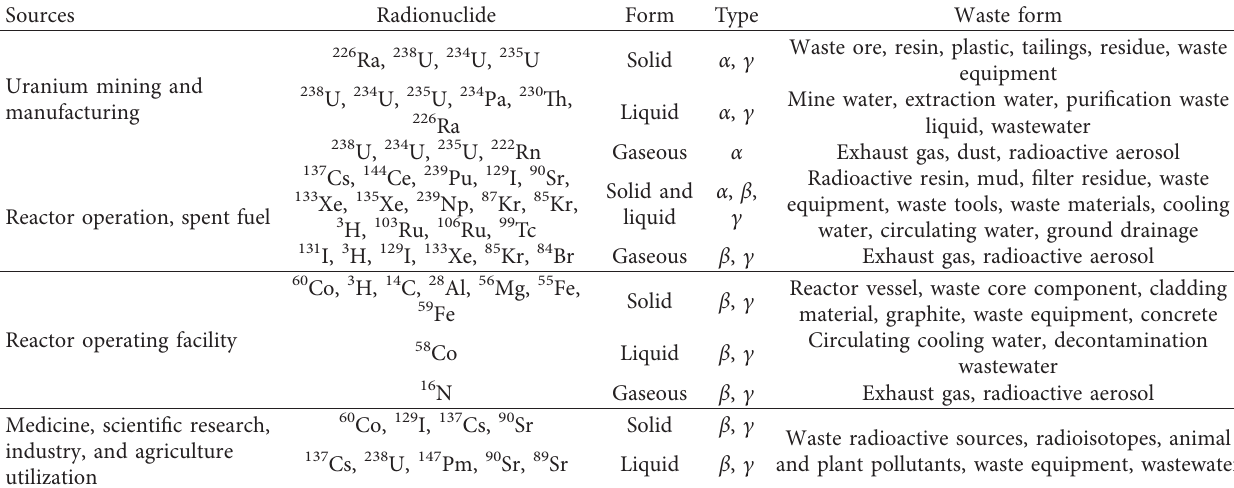
Table 1: Main sources and types of radionuclides [4,